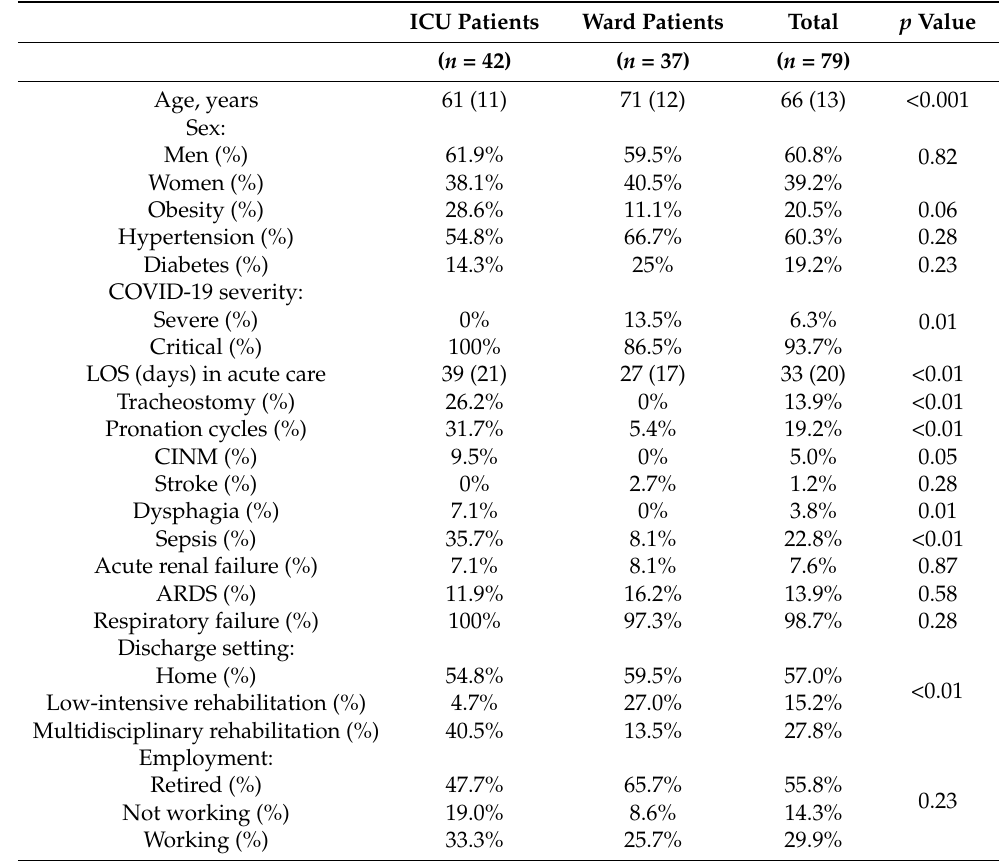
Table 2. Demographic and clinical characteristics of COVID-19 patients admitted to ordinary wards and intensive care units. Abbreviations: ICU= Intensive Care Unit; CINM = Critical Illness Neuromy- opathy; ARDS = Acute Respiratory Distress Syndrome; LOS = Length of